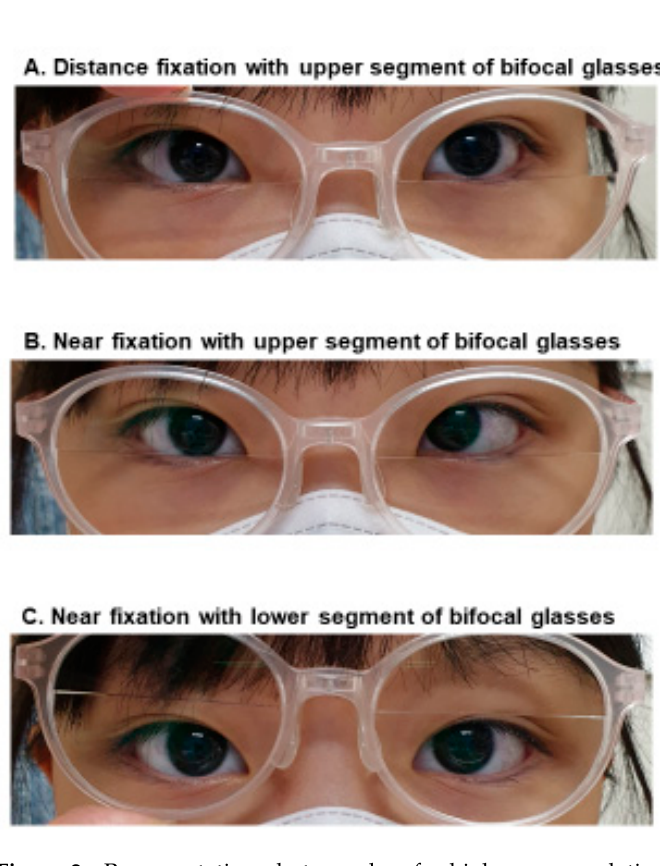
Figure 2. Representative photographs of a high accommodative convergence/accommodation (AC/A) ratio consecutive esotropia patient. Ocular alignment at distance fixation using the upper segment of bifocal glasses (upper), at near fixation using the upper segment of bifocal glasses (middle), and at near fixation using the lower segment of bifocal glasses (lower).